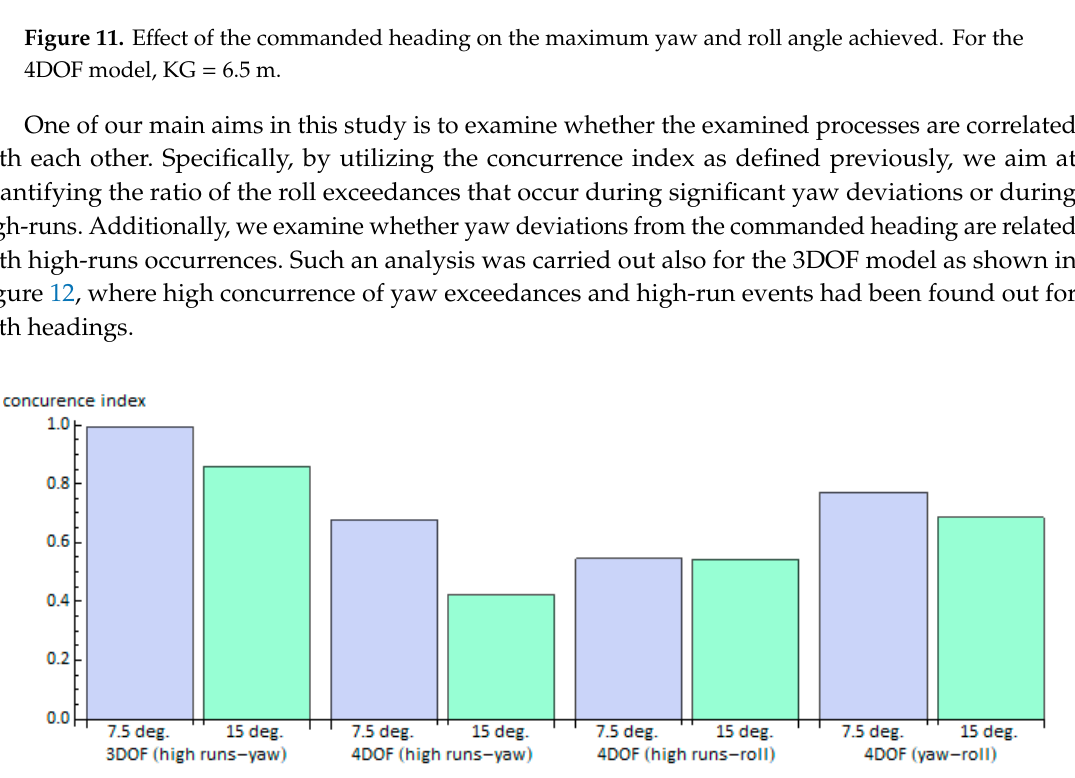
Figure 12. Effect of the commanded heading on the concurrence index. For the 4DOF model, KG = 6.5 m.